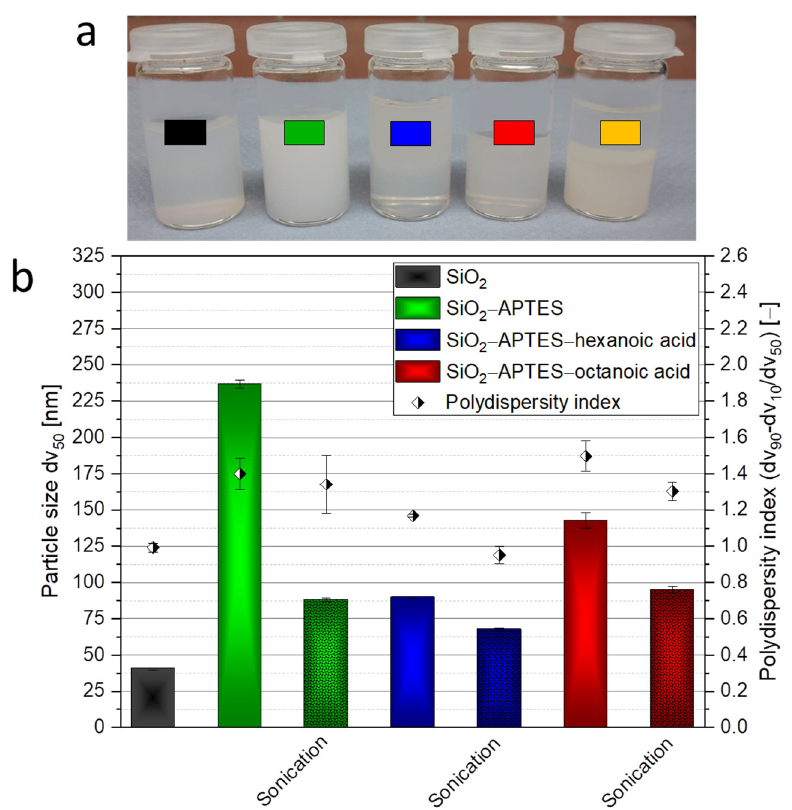
Figure 6. Photograph of silica suspensions ( a ) as well as DLS measurements of the particle size and particle size distributions of the unmodified and modified silica nanoparticles ( b ). ( a ) Suspensions in the solvent ethanol (black: SiO 2 as a reference; green: SiO 2 –APTES; blue: SiO 2 –APTES–hexanoic acid; red: SiO 2 –APTES–octanoic acid; orange: SiO 2 –APTES–decanoic acid). ( b ) SiO 2 as a reference and modified particles (SiO 2 –APTES, SiO 2 –APTES–hexanoic acid, and SiO 2 –APTES–octanoic acid) in ethanol with and without sonication. SiO 2 –APTES–decanoic acid could not be measured due to strong sedimentation.